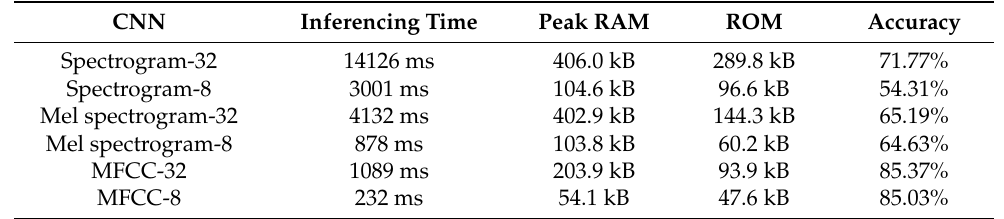
Table 3. CNN performance comparison adopting different pre-processing techniques. CNN Inferencing Time Peak RAM